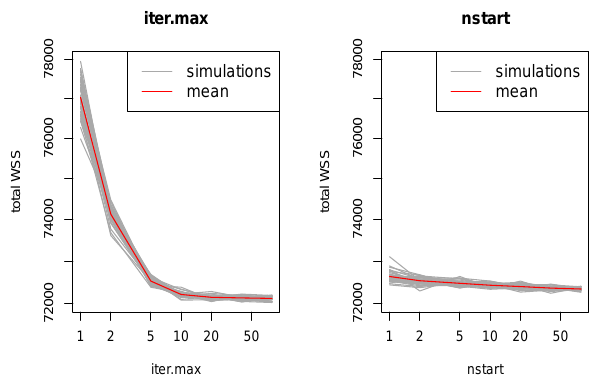
Fig. 2. The effect of maximum allowed iterations (iter.max) and number of random starts (nstart) of Kmeans on total within sum of squares (WSS) of resulting clusters ( k =